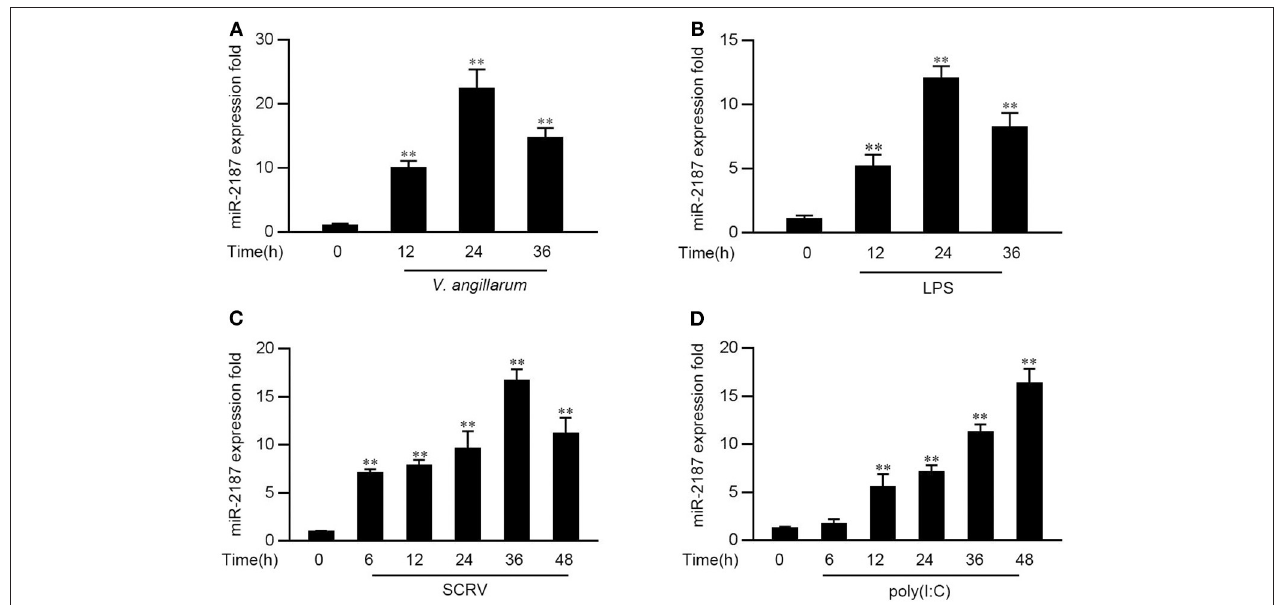
FIGURE 1 | The expression profiles of miR-2187 following Gram-negative bacteria and RNA viral treatment. (A) The expression profile of miR-2187 in miiuy croker liver tissues of different time points after infection of the V. anguillarum was detected by qRT-PCR. (B) The expression profiles of miR-2187 in LPS-stimulated miiuy croaker liver samples. (C,D) The expression profiles of miR-2187 in miiuy croaker spleen tissues were measured by qRT-PCR at indicated time after poly(I:C) (C) or SCRV (D) stimulation. The miR-2187 expression levels were all measured by qRT-PCR and normalized to 5.8S rRNA. Results are standardized to 1 in control samples. All data represented the mean ± SE from three independent triplicated experiments. ** p < 0.01 vs. the